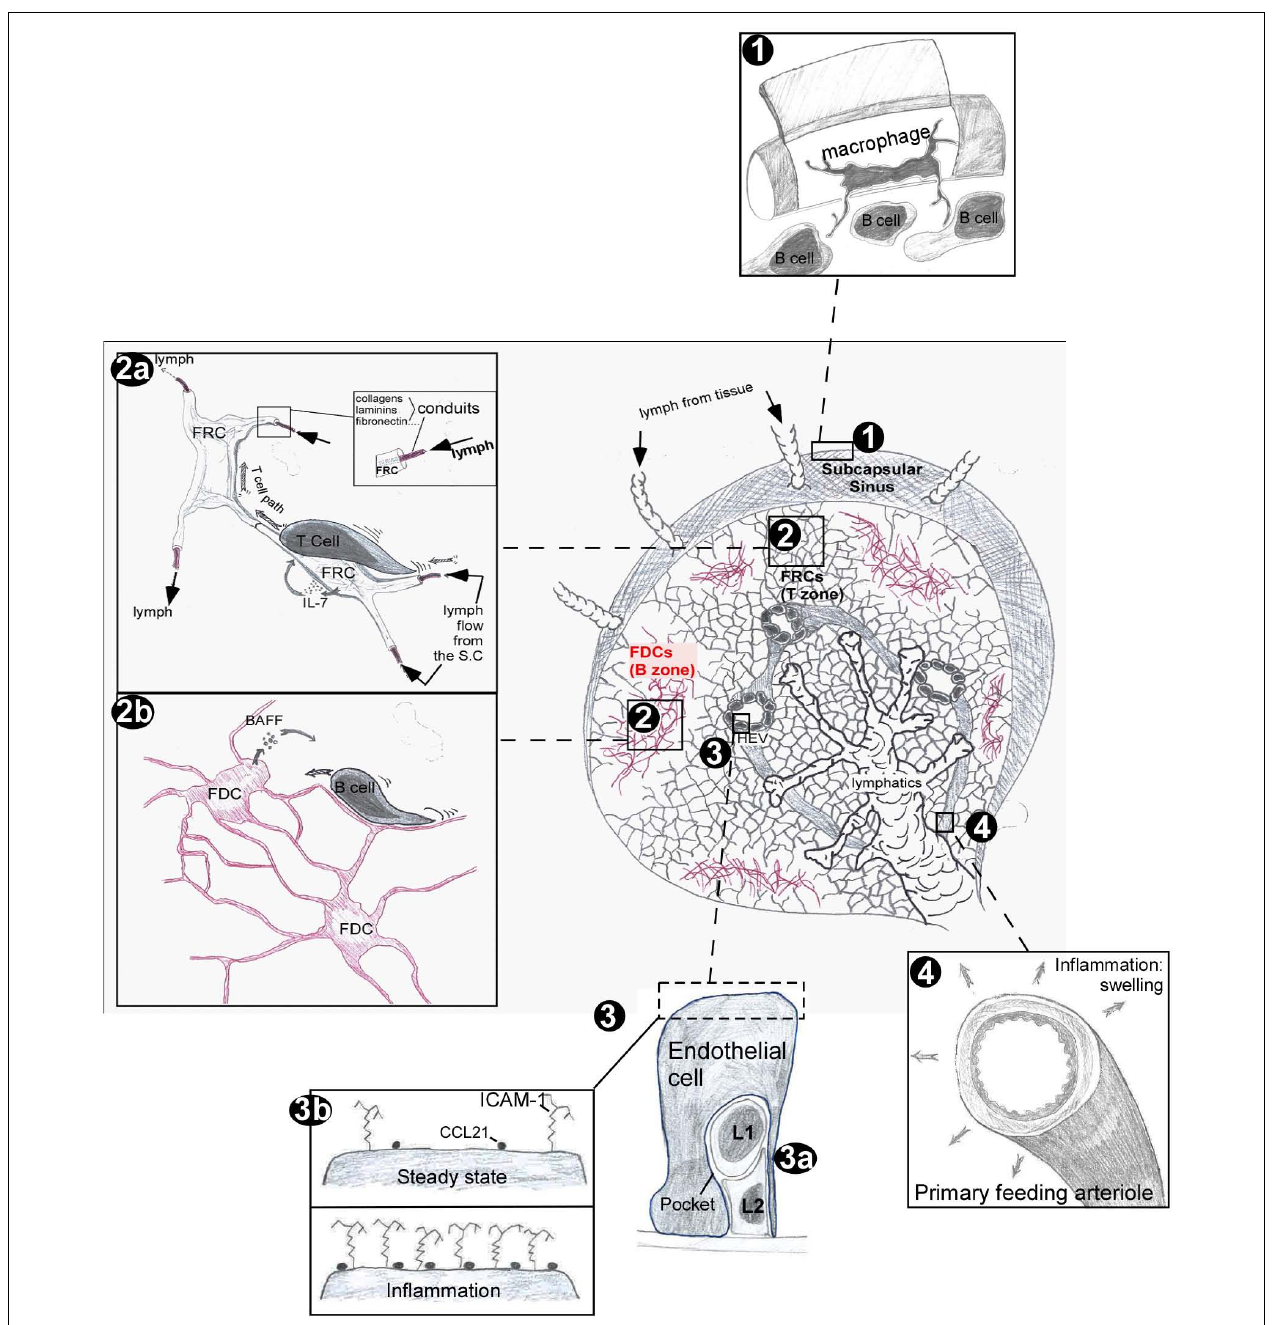
FIGURE 1 | Stromal cell guided transport of soluble material and immune cells within lymph nodes.